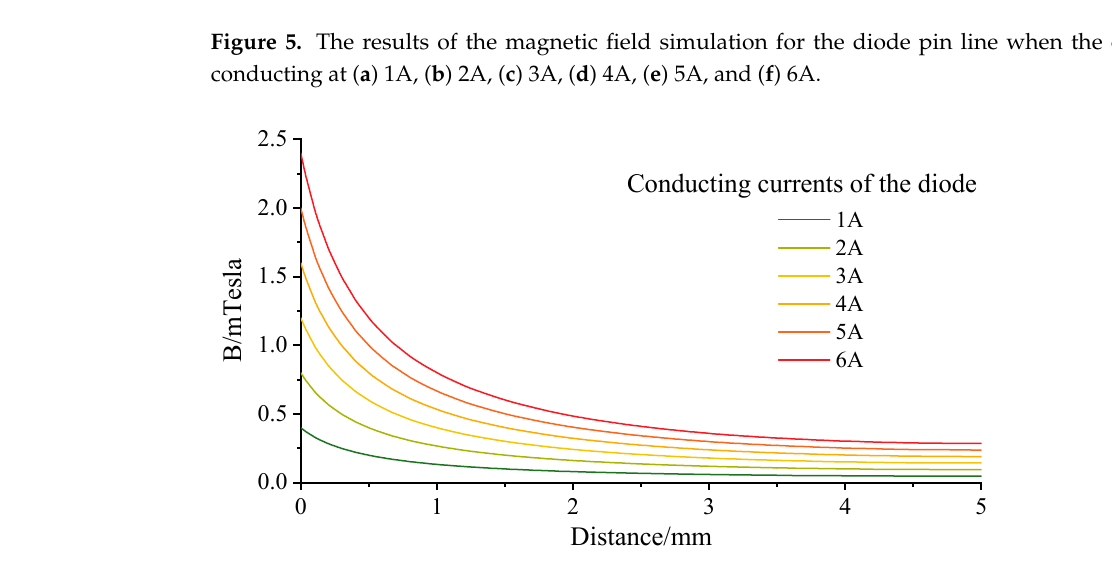
Figure 6. The curves indicating the relationship between the magnetic induction intensity and the distance in space to the surface position of the diode pin line.